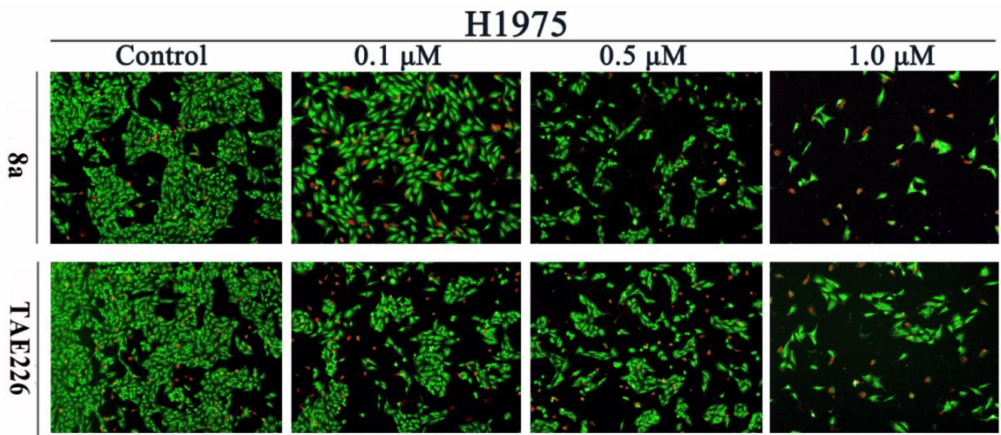
Figure 4. Apoptotic morphology of H1975 cells was assessed by AO/EB double fluorescent staining (100 × , final magnifica-